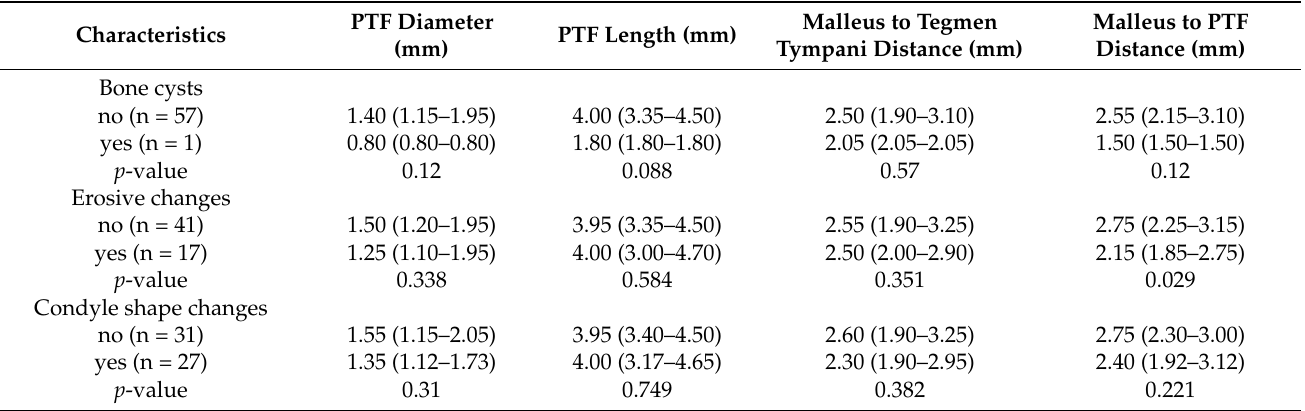
Table 6. PTF dimensions and malleus position related to condylar